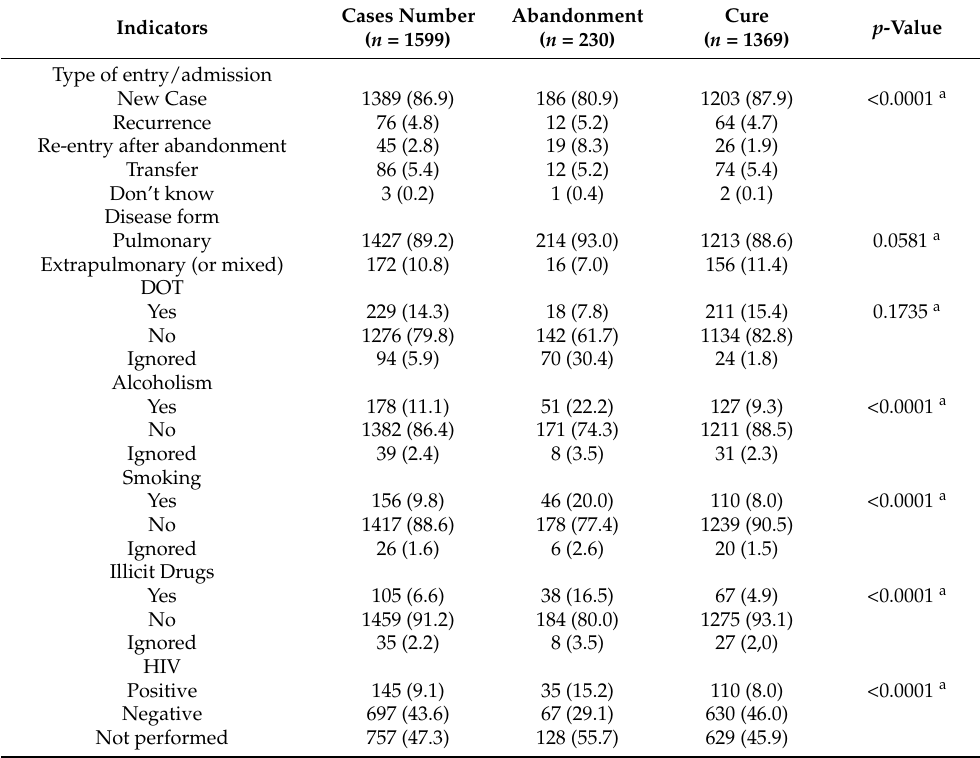
Table 4. Epidemiological characteristics of the cases with the Treatment abandonment outcome and Tuberculosis cure in Ananindeua from 2017 to